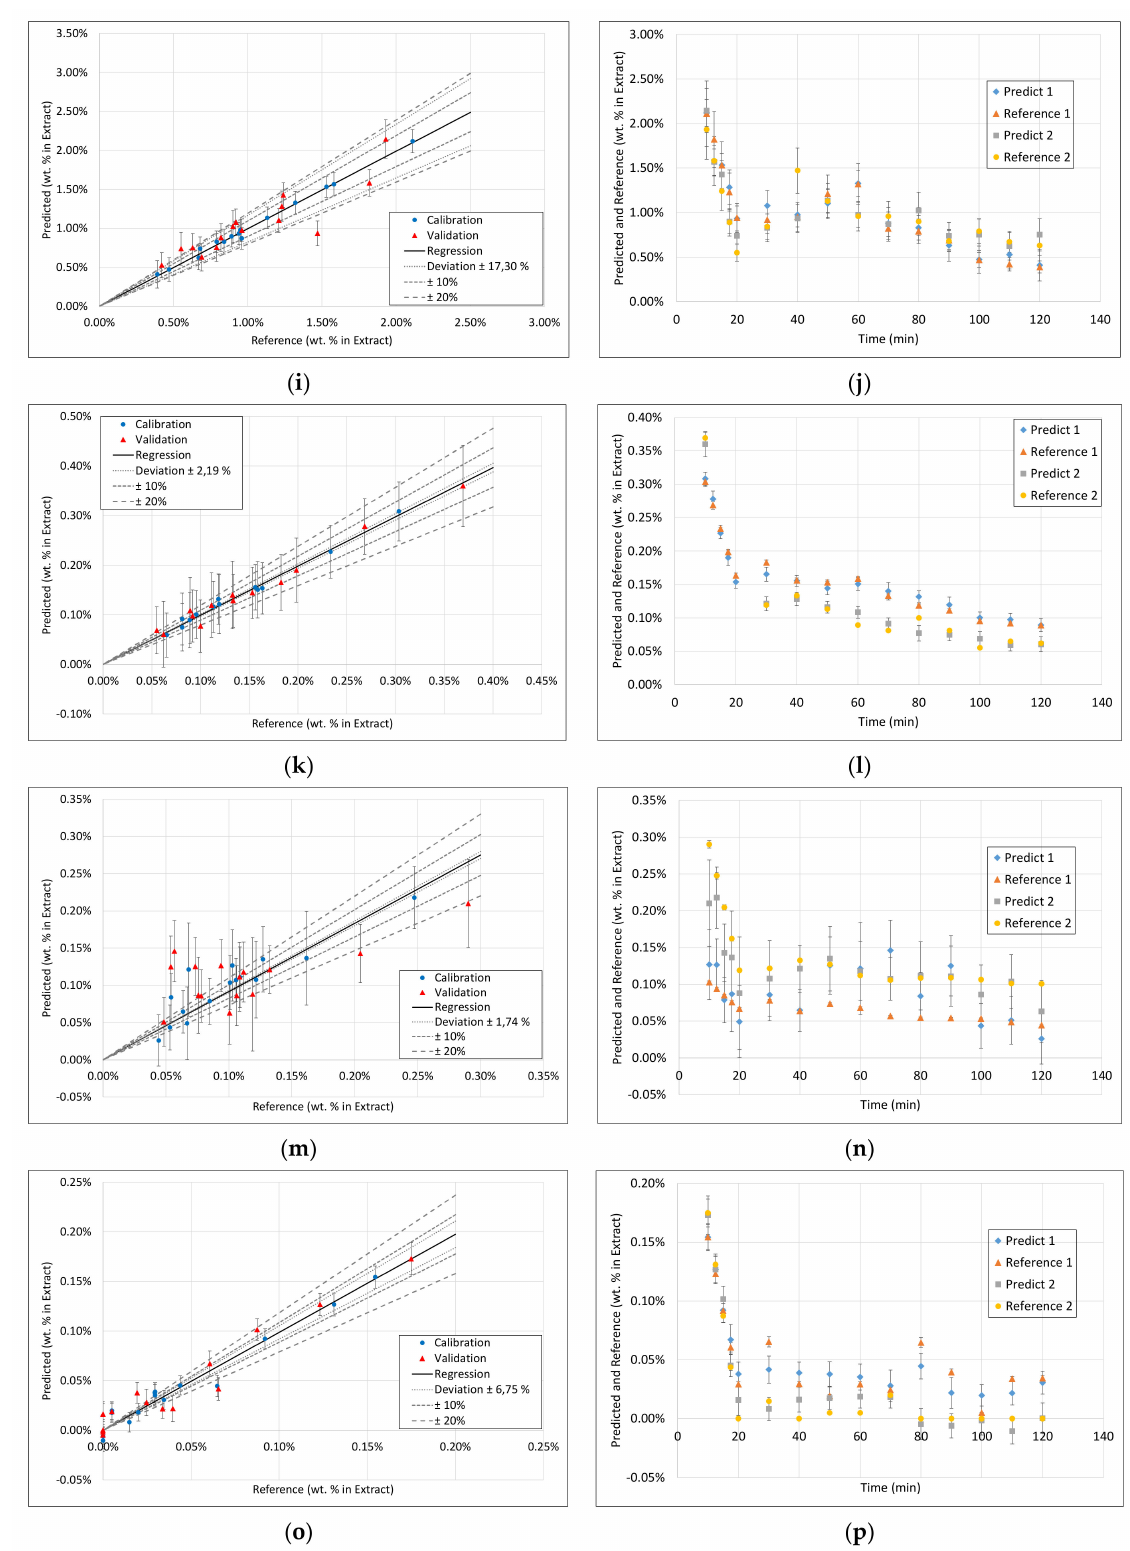
Figure A1. FTIR half-normal plots and measured vs. predicted extraction profiles for ( a , b ) dry residue, ( c , d ) arbutin, ( e , f ) total phenolic content, ( g , h ) sugar monomers, ( i , j ) structural carbohydrates, ( k , l ) aminic acids, ( m , n ) proteins, and ( o , p )